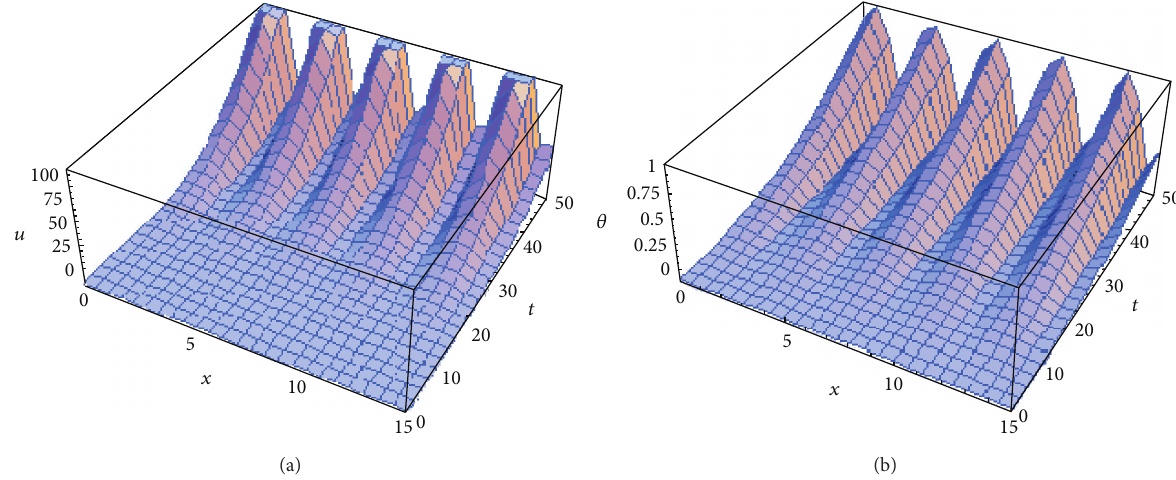
Figure 3: Variations of the displacement 𝑢 and the temperature 𝜃 for various values of the 𝑥 -axis and time 𝑡 when 𝜏 2 = 0 , 𝜏 1 = 0.1 , 𝛿 = 1 , = 0.2 , 𝜎 = 0.1 , Ω = 0.1 , and 𝜔 = 0.02 𝜎 1 2